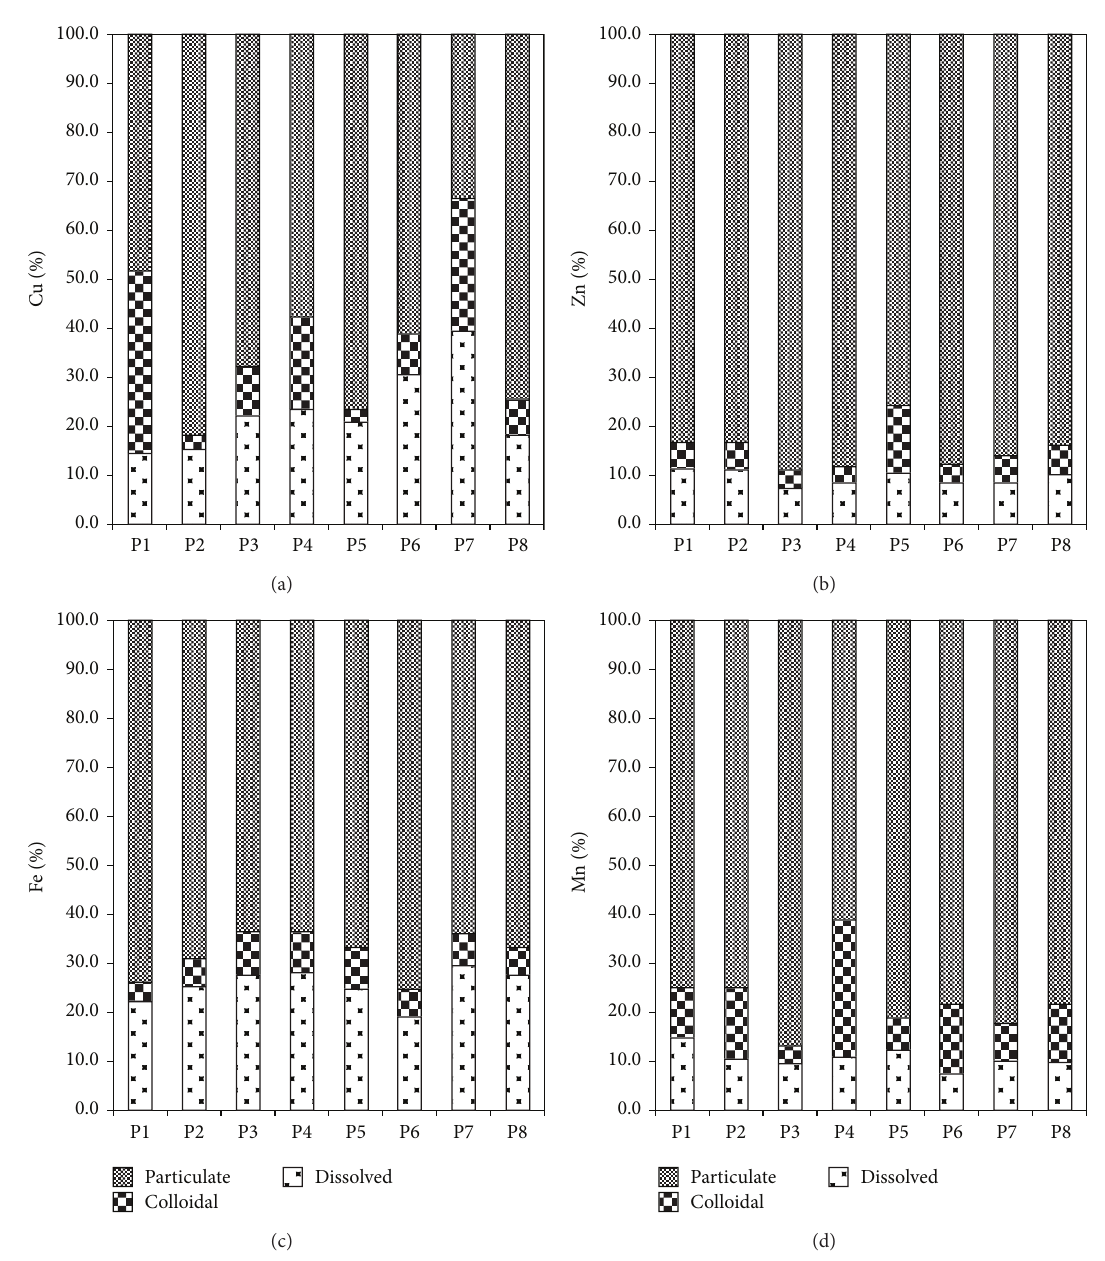
Figure 2: Metals distribution (% of the total elements concentration) in DGT-labile fraction, in colloids, and in particulates in Aries River and tributaries (dis: dissolved (DGT-labile)); col: colloidal (total dissolved − DGT-labile); part: particulate (total − total dissolved (0.45 𝜇